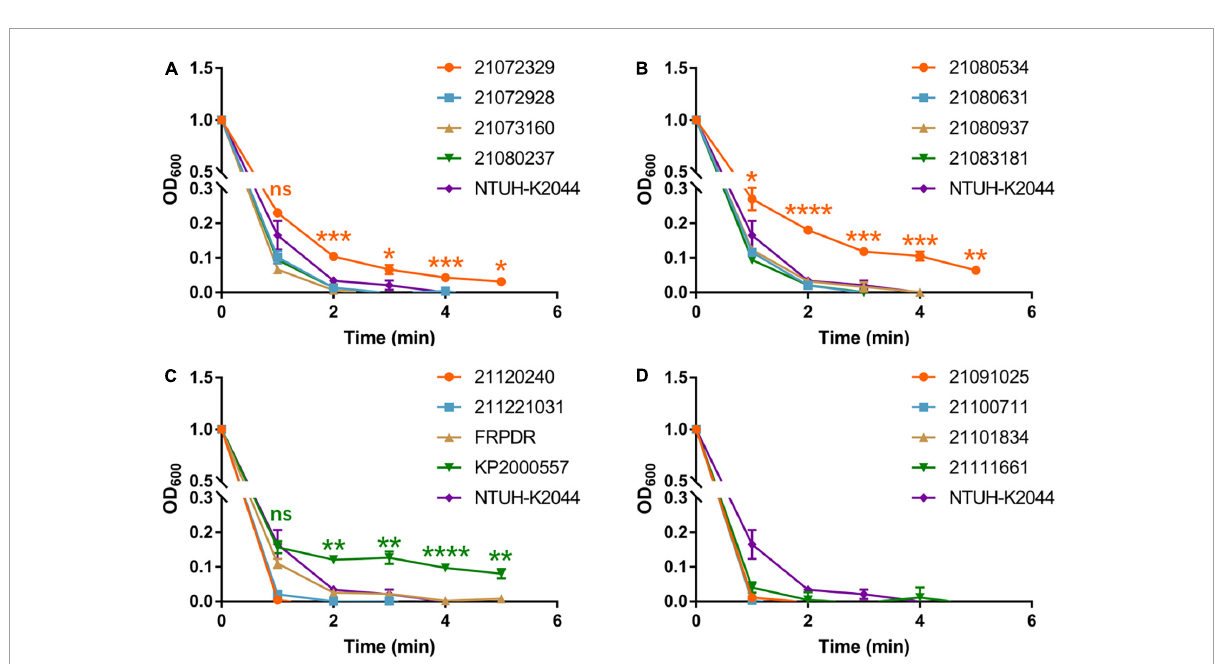
FIGURE2 ST11 K. pneumoniae isolates exhibit characteristics of hypermucoviscosity. Viscosity levels of the isolates were determined by the OD 600 of the supernatant obtained after centrifugation of the overnight culture at 2,350 g for 5 min. (A–D) Are the mucoviscosity assay results of ST11 K. pneumoniae isolates. * P < 0.05, ** P < 0.01, *** P < 0.001, **** P < 0.0001.